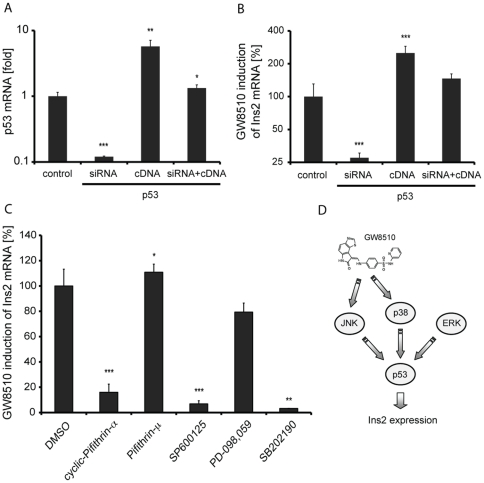
Effects of manipulation of p53 levels and activity on induction of Ins2 by GW8510 treatments.(A) Experimental knockdown and over-expression of p53 in alpha cells and (B) its effects on Ins2 induction by 3-day treatment with 1.65 µM GW8510. (C) Co-treatment with small molecule inhibitors of p53 and upstream targets in the p53 signalling pathway and their effect on Ins2 induction following treatment with GW8510. (D) Proposed model for GW8510-mediated induction of insulin expression via activation of p53 transcriptional activity. All data represent the mean±SD of at least three experiments; *p<0.05, **p<0.01 and ***p<0.001.